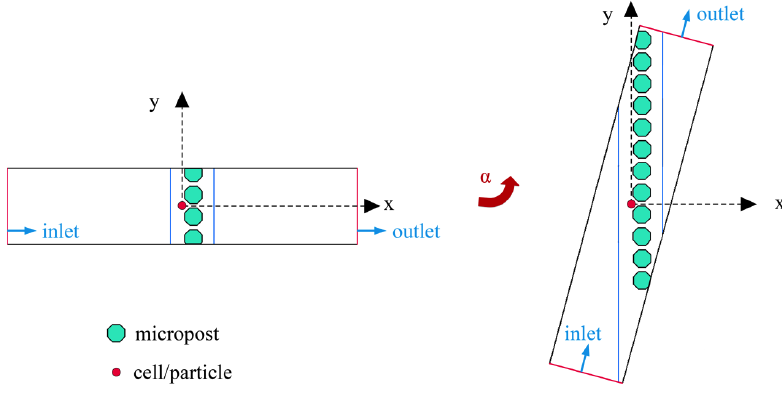
Figure 2. Geometry for simulating the particle trajectories.